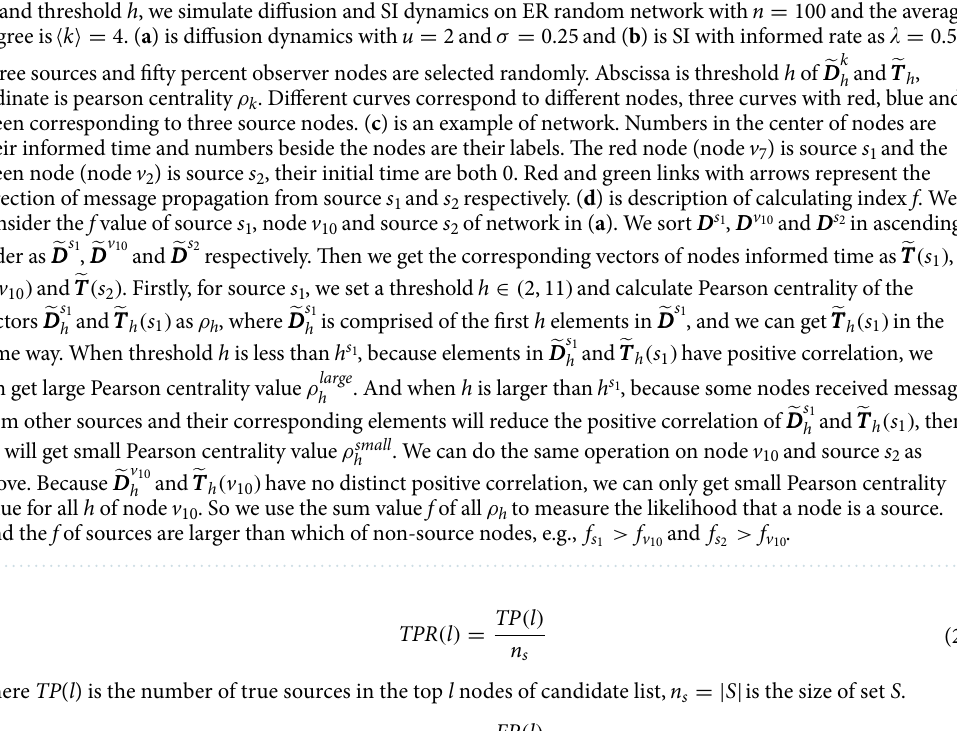
k DDD TTT h , h and (cid:31) (cid:31)